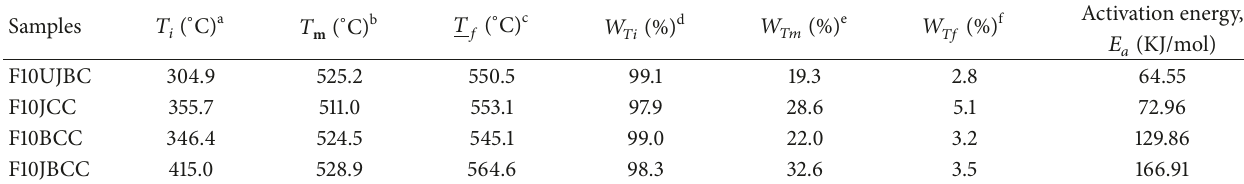
Table 2: Comparison of activation energy among hybrid composites at 10wt% fiber loading. Samples